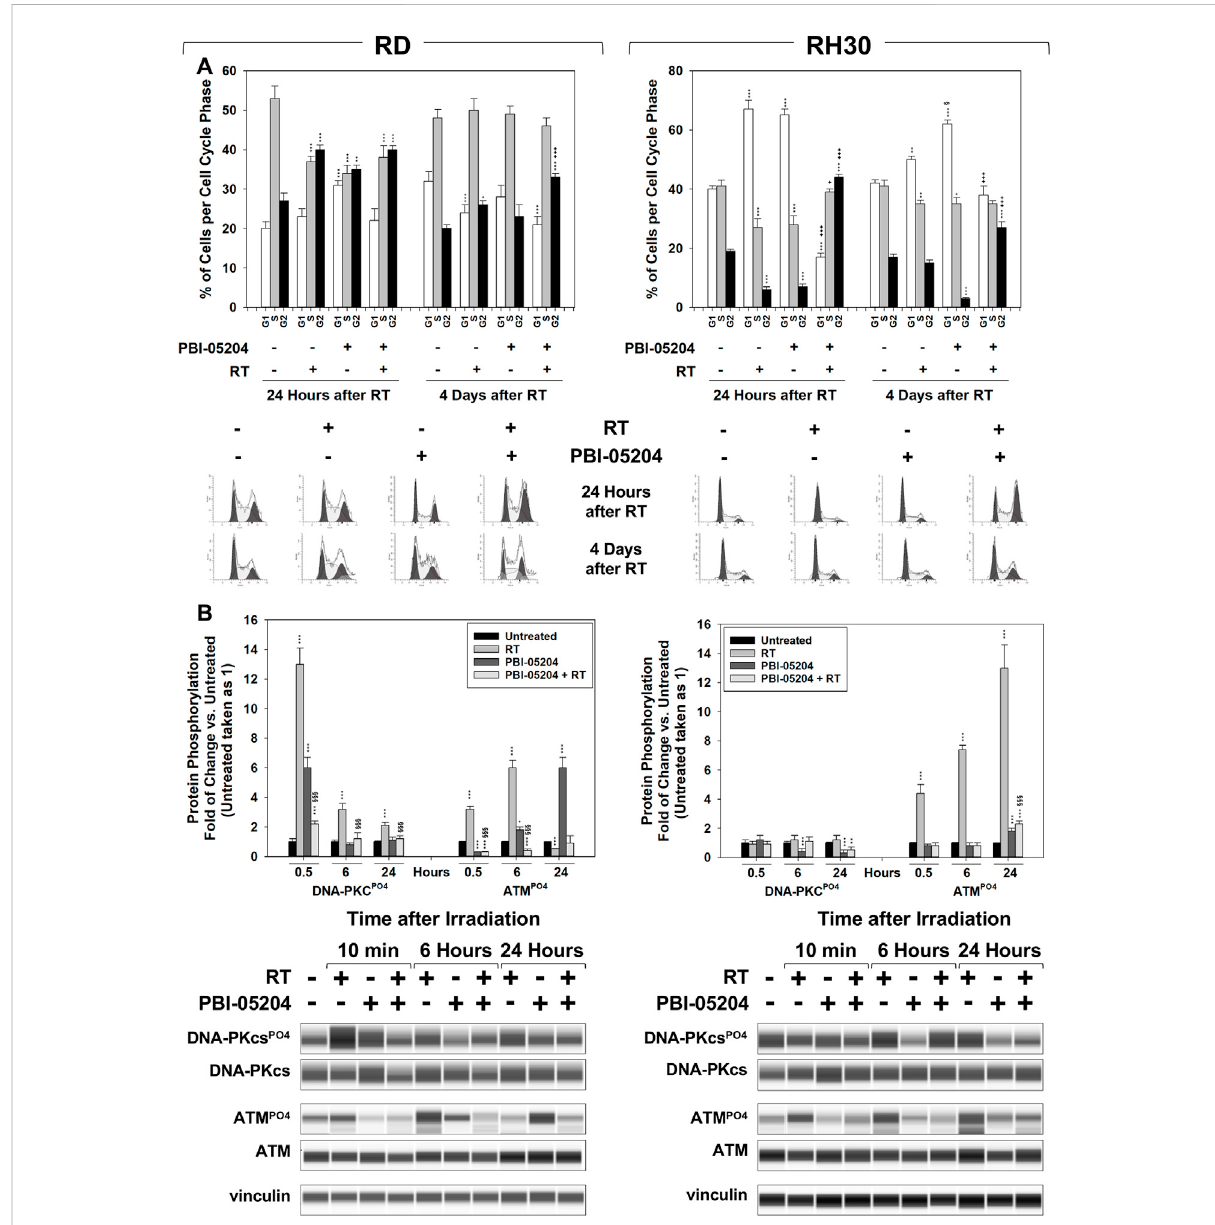
FIGURE 6 PBI-05204 promotes RT-induced accumulation of cancer cells in theG2 phase of thecell cycle and counteracts theability ofFN-RMS and FP- RMS to repair damaged DNA. (A) FACS analysis performed on RD (Left) and RH30 (Right) treated with PBI-05204 (IC 50 ), RT alone or with the combination.Data(Up)showthepercentageofcellsineachcellcyclephaserepresentingthemeanvalueofthreeindependentexperiments.(Down) Representative data from three independent experiments is shown. (B) Cell lysates from RD (Left) and RH30 (Right) cells pre-treated for 24 h with PBI-05204 (IC50) and then irradiated with 4 Gy were collected 10 min, 6 and 24 h after RT. Cell lysates were analyzed by immunoblotting with speci fi c antibodies for the indicated proteins; vinculin expression was used as a loading control. Histograms (Up)of densitometric analysis represent the mean values of three independent experiments ±SD. Statistical signi fi cance: ** p ≤ 0.01, *** p ≤ 0.001 vs. Untreated cells, § p ≤ 0.05, §§ p ≤ 0.01, §§§ p ≤ 0.001 vs. RT, + p ≤ 0.05, ++ p ≤ 0.01, +++ p ≤ 0.001 vs. PBI-05204. A representative of three independent experiments is shown